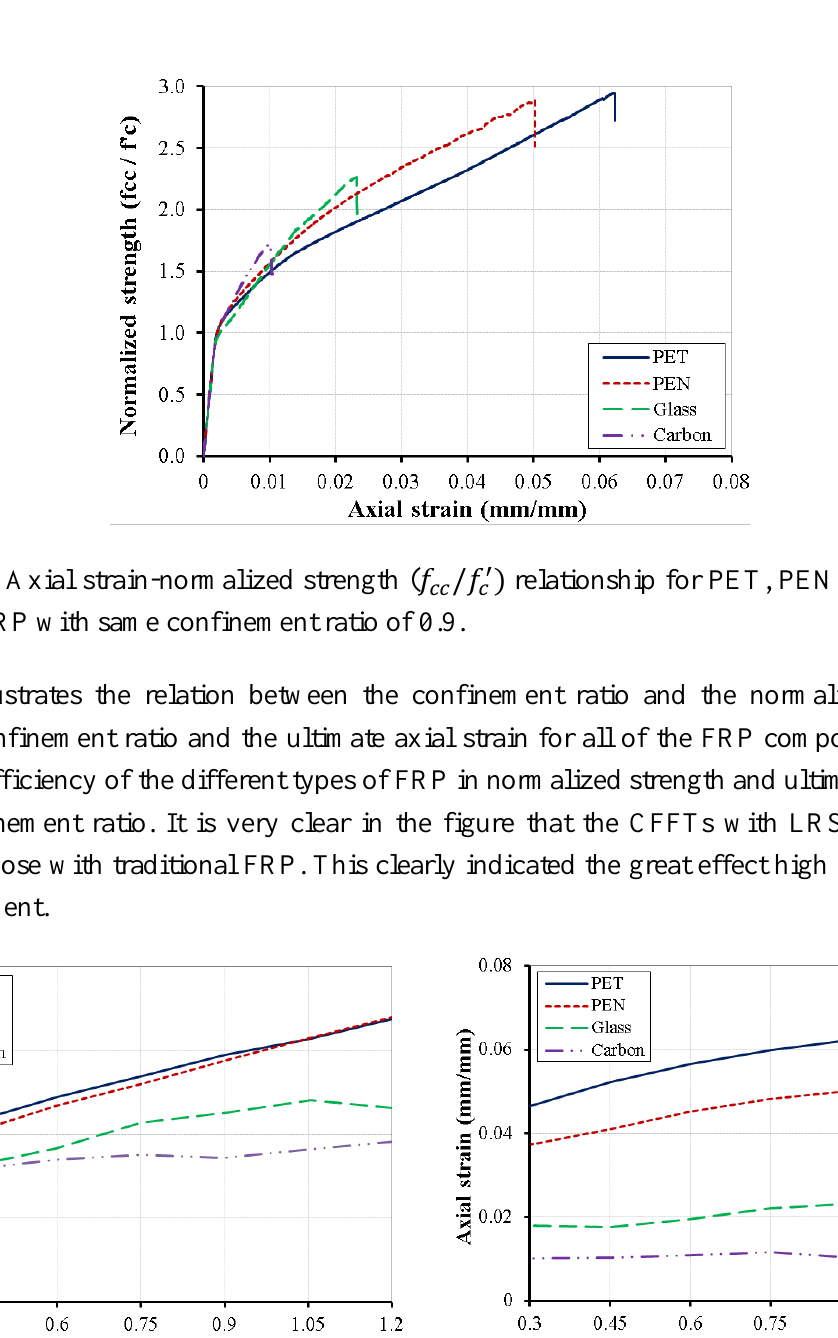
Figure 5. Efficiency of the traditional versus LRS-FRP composites in: ( a ) normalized axial strength; ( b ) axial